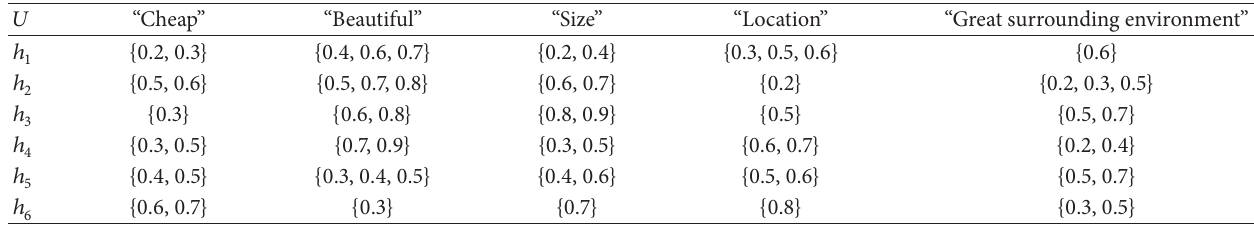
Table 3: The tabular representation of the hesitant fuzzy soft set